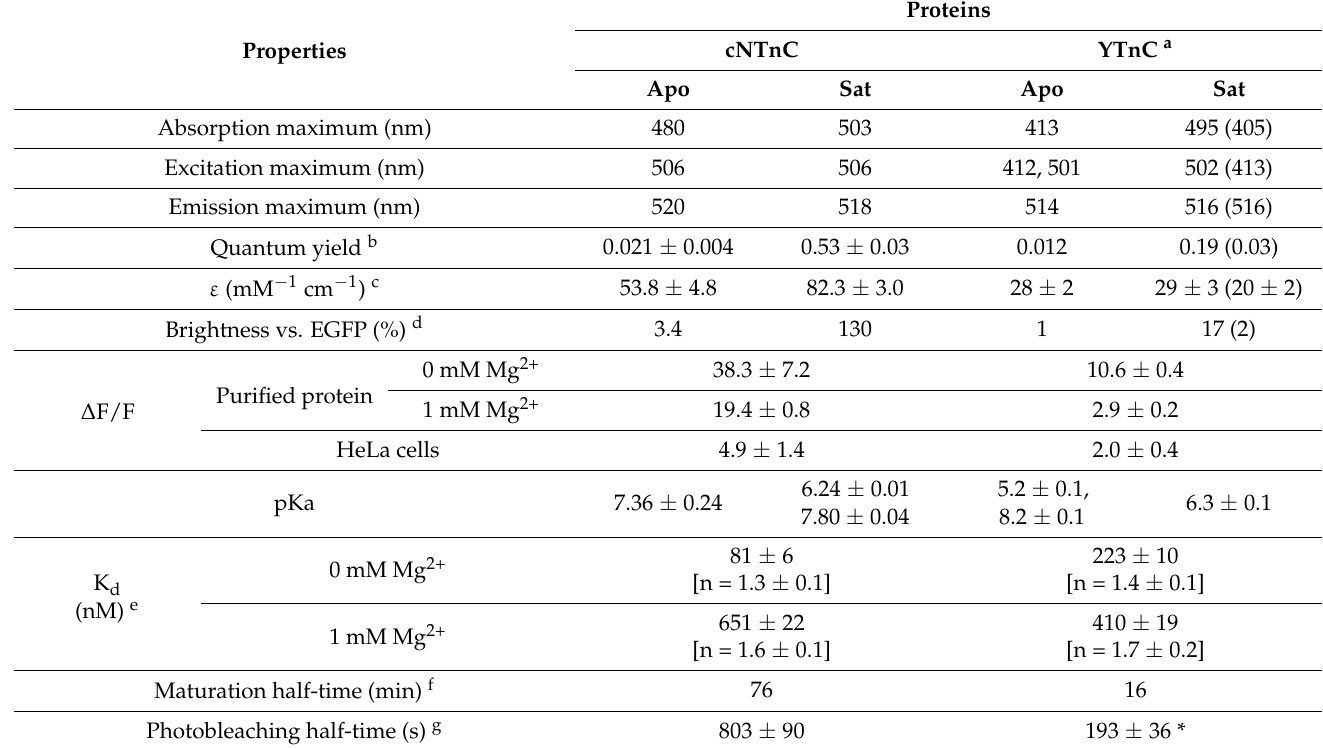
Table 4. In vitro properties of cNTnC compared to YTnC. a Data from [11]. Data marked with an asterisk (*) were determined in this paper. b Quantum yields (QYs) were determined at pH 7.20. EGFP (QY = 0.60 [20]) was used as the reference standard. c The extinction coefficients ( ε ) were determined using alkaline denaturation. d Brightness was calculated as a product of the quantum yield and extinction coefficient and normalized to the brightness of EGFP, which has an extinction coefficient of 56,000 M − 1 · cm − 1 and a quantum yield of 0.6 [20]. e The Hill coefficient is shown in brackets. f EGFP had a maturation half-time of 14 min. g Half-time to bleaching up to 50%. One-photon photobleaching was performed under a mercury lamp with drops in oil. Standard deviations are shown. EGFP had a photobleaching half-time of 305 ± 38